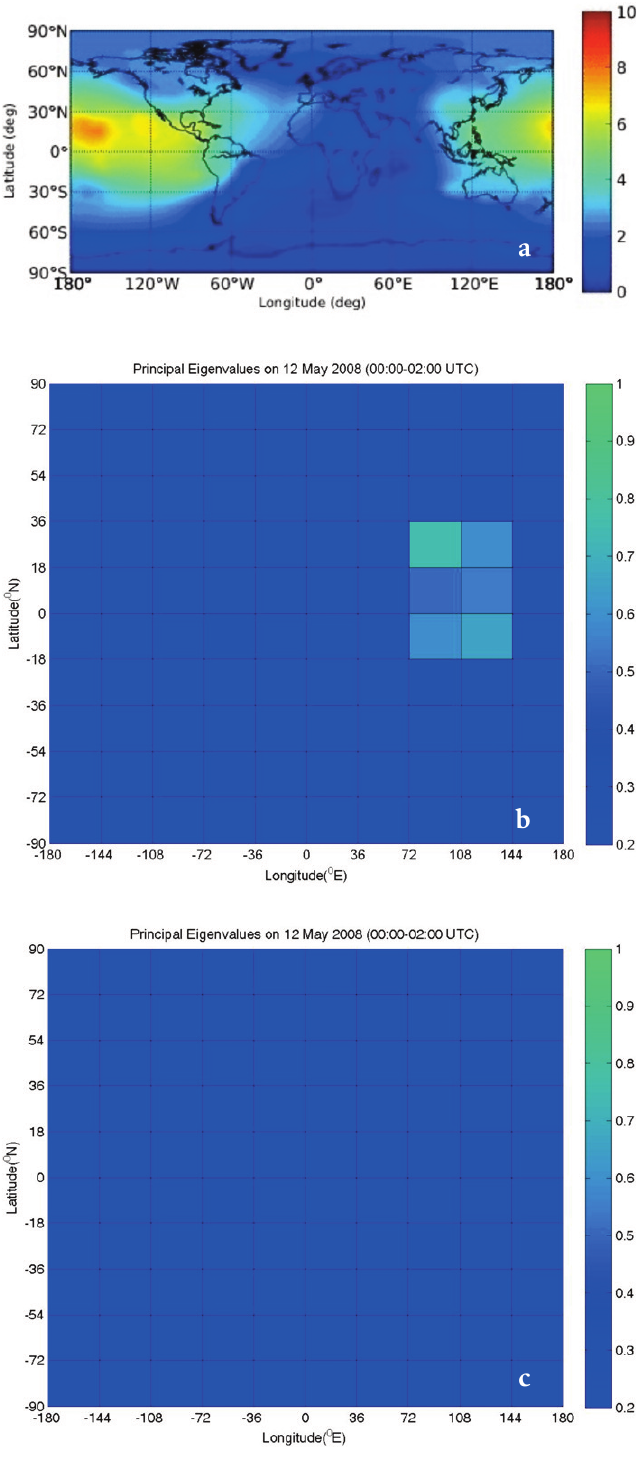
Figure 1. (a) The GIM on May 12, 2008, at heights of 150 km to 450 km for the time period 00:00-02:00 UT. (b, c) Color-coded scales of the magnitudes of principal eigenvalues using NLPCA (b) and PCA (c) corresponding to (a). The colors within the grids give the magnitudes of a principal eigenvalue corresponding to (a), so that there are 100 principal eigenvalues assigned (i.e., each grid represents a principal